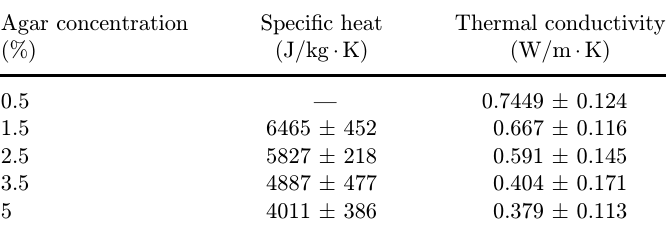
Table 3. Measured speci¯c heat (J/kg (cid:5) K) and thermal conductivity (W/m (cid:5) K) at various concentrations of agar-gels used to fabricate skin tissue phantoms.